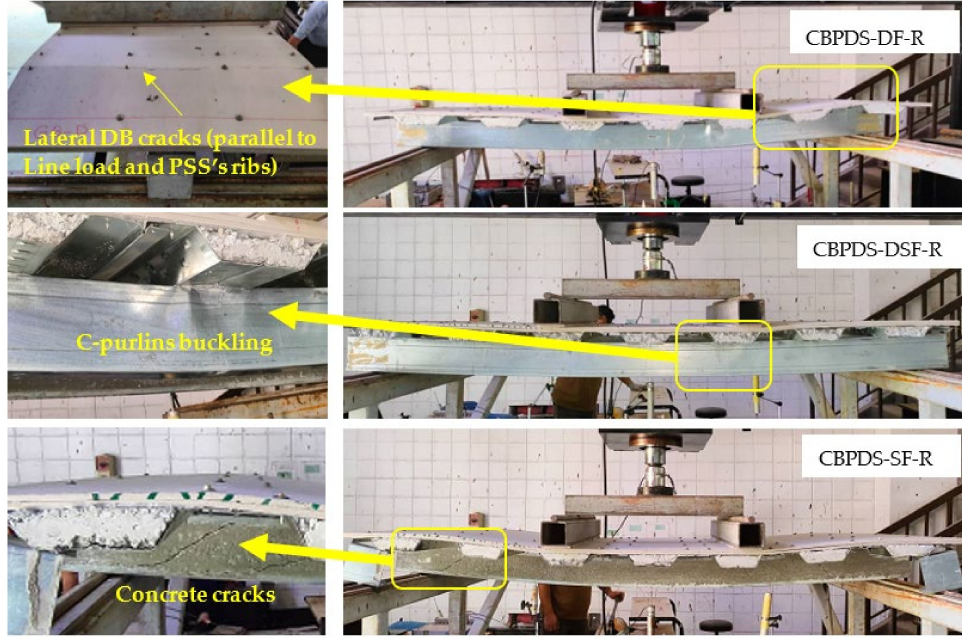
Figure 12. Bending behavior of the CBPDS specimens with perpendicular PSS